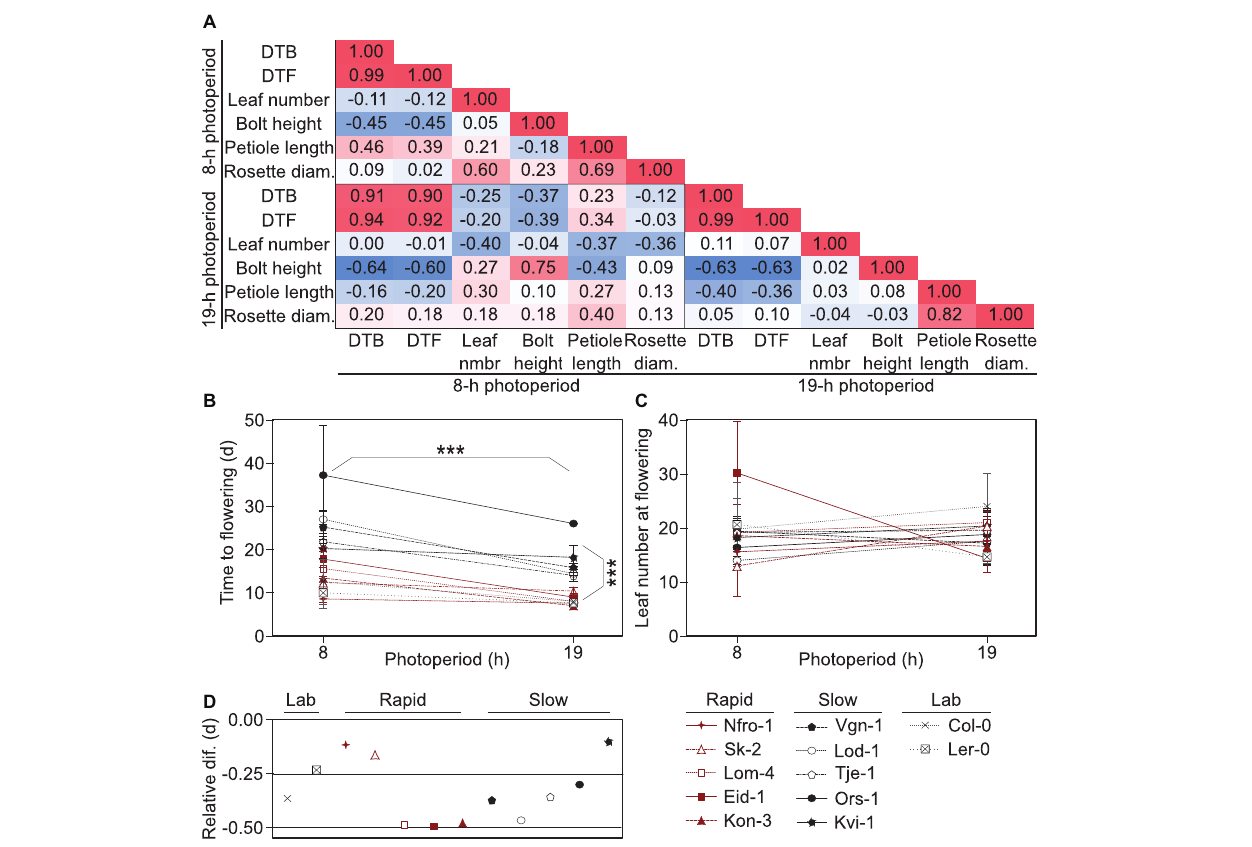
FIGURE 1 | Flowering growth forms and behaviors vary across accessions. (A) Pearson correlation matrix showing the correlations between days to bolt (DTB) and days to flowering (DTF) post vernalization, rosette leaf number, flowering stem (bolt) height, leaf petiole length, and rosette diameter at flowering among Arabidopsis accessions originating from throughout Norway and grown in 8- or 19-h photoperiods. Red indicates positive correlation and blue indicates negative correlation with the higher intensity hues indicating stronger correlations. (B,C) Flowering time for plants grown in 8- and 19-h photoperiods as measured by days post vernalization prior to production of a visible bolt (DTB, B ) or as final rosette leaf number (C) . Asterisks indicate significance between the two photoperiod treatments and flowering types: rapid- flowering and slow -flowering post vernalization, as indicated by visible separation in the 19-h photoperiod treatments in DTB. Points and lines are color-coded by flowering type: rapid (red), slow (black), or lab (gray). Points represent means of five individuals for each accession and individual, except for those classified as “lab” accessions which represent three individuals. Lab accessions are included in the plot for visual comparison but were not included in the statistical analysis. Error bars are standard deviations. For some points, error bars are smaller than the diameter of the points and therefore not visible. (D) Relative change in flowering, calculated as the ratio between the difference in DTB in the 19- and 8-h photoperiods and DTB in the 8-h photoperiods. Across all accessions, flowering is earlier in the 19-h photoperiod relative to the 8-h photoperiod. Those points closer to zero show a smaller difference in DTB between the two treatments. The flowering time data is a subset of data previously reported in Lewandowska-Sabat et al. (2017). Nfro-1 and Lod-1 flower earlier with vernalization but do not require it to flower (Lewandowska-Sabat et al.,